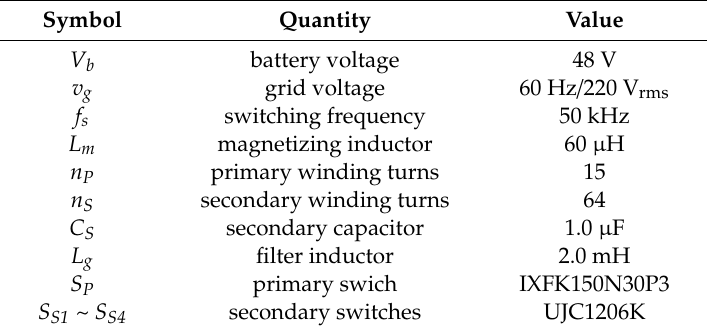
Table 1. Key parameters and components.